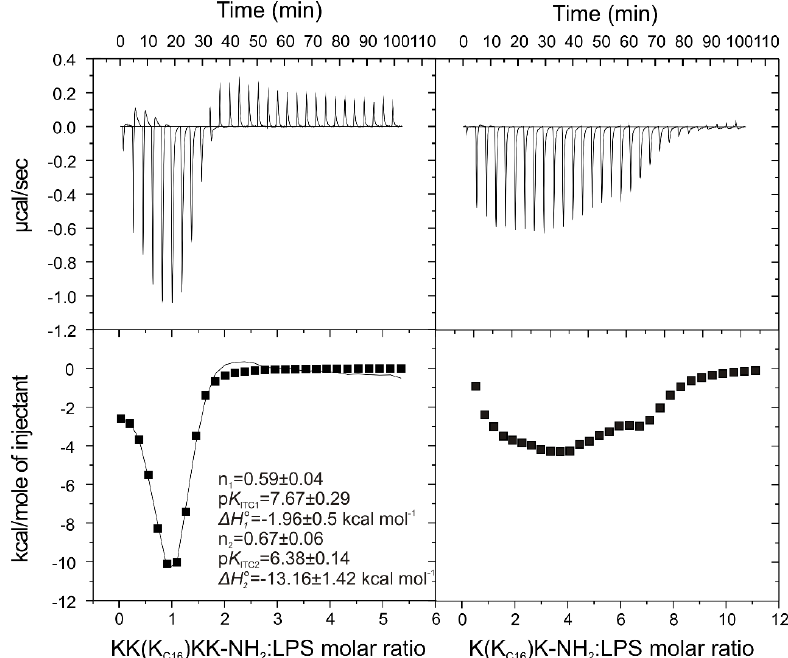
Figure 5. Isothermal titration calorimetry (ITC) traces showing heat changes upon titration of the 0.5 mM KK(K C16 )KK-NH 2 ( I ) and 0.5 mM K(K C16 )K-NH 2 ( V ) to 0.02 mM (400 µg/mL) or 0.01 mM (200 µg/mL) LPS E. coli 055:B5, respectively. The bottom curves represent the heat of reaction (measured by peak integration) vs. the lipopeptide/LPS molar ratio.